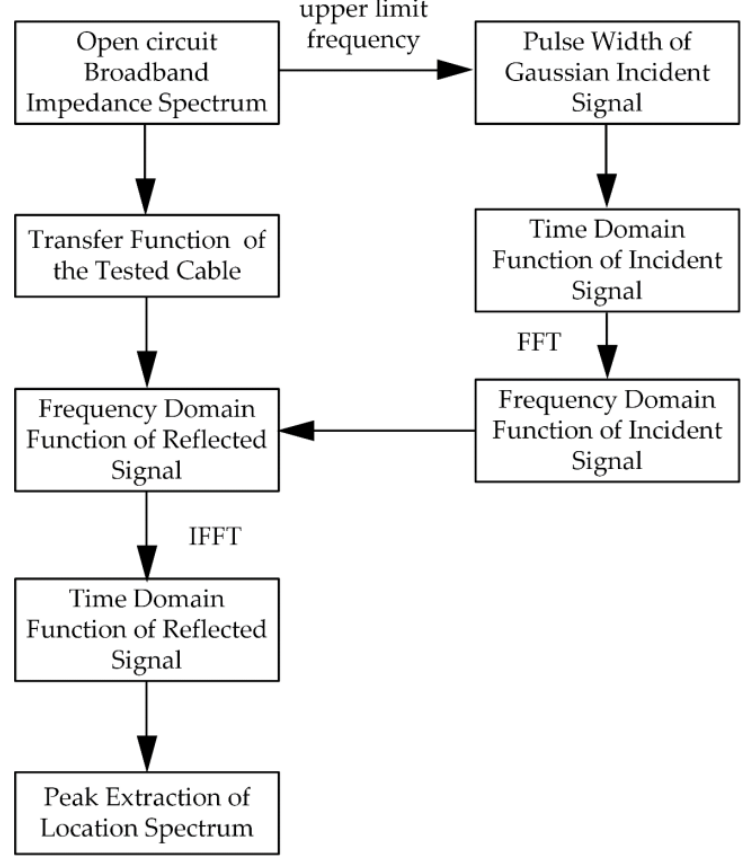
Figure 2. The calculation process of the BIS locating algorithm.